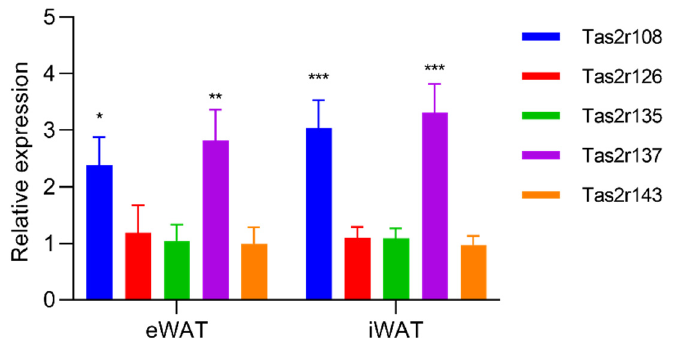
Figure 4. Stimulation by epicatechin upregulated the expression of Tas2r genes in mouse white adipose tissue (WAT). Mouse epididymal WAT (eWAT) and inguinal WAT (iWAT) were stimulated with epicatechin (EC, 2.5 mM) for 3 h. Tas2r expression was determined by RT-qPCR analysis. Actb was used as the reference gene. N = 6, * p < 0.05, ** p < 0.01, *** p < 0.001 (stimulated vs. control, t -test).